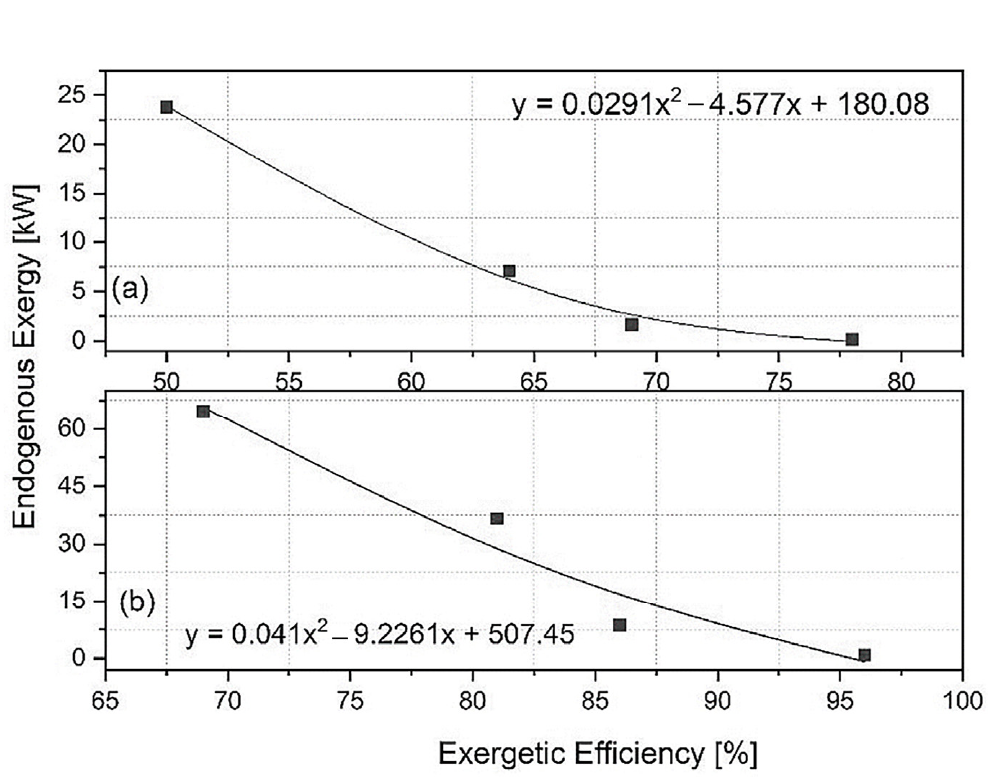
Figure 7. Endogenous curve ( a ) pump-2, and ( b ) turbine.